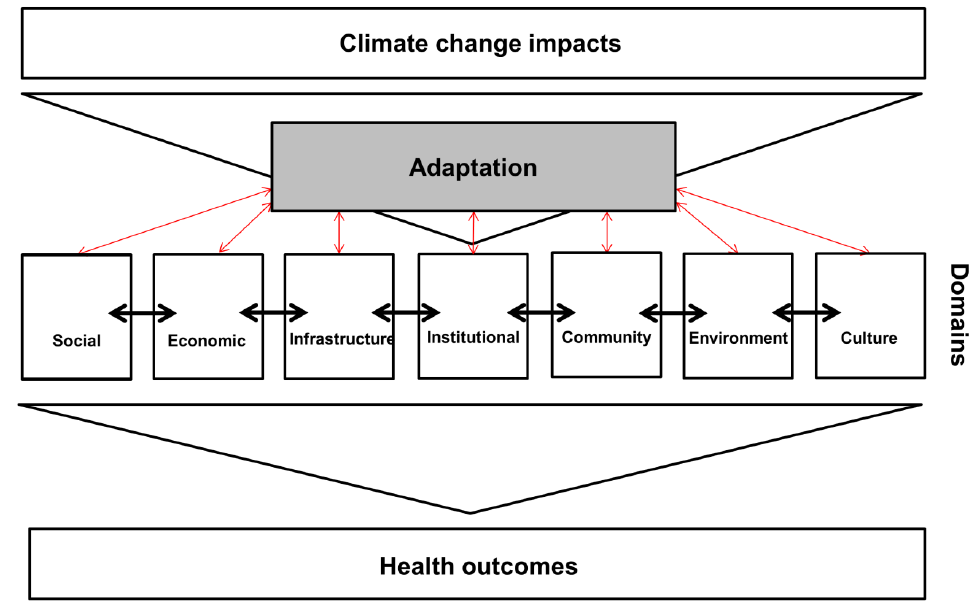
Figure 1. The domain-driven theoretical framework to evaluate adaptation based on justice concerns. Evaluation projects should target the associations between adaptation and each of the seven domains. Table 1. Possible operational indicators for each domain (adapted from [6,53,54]).